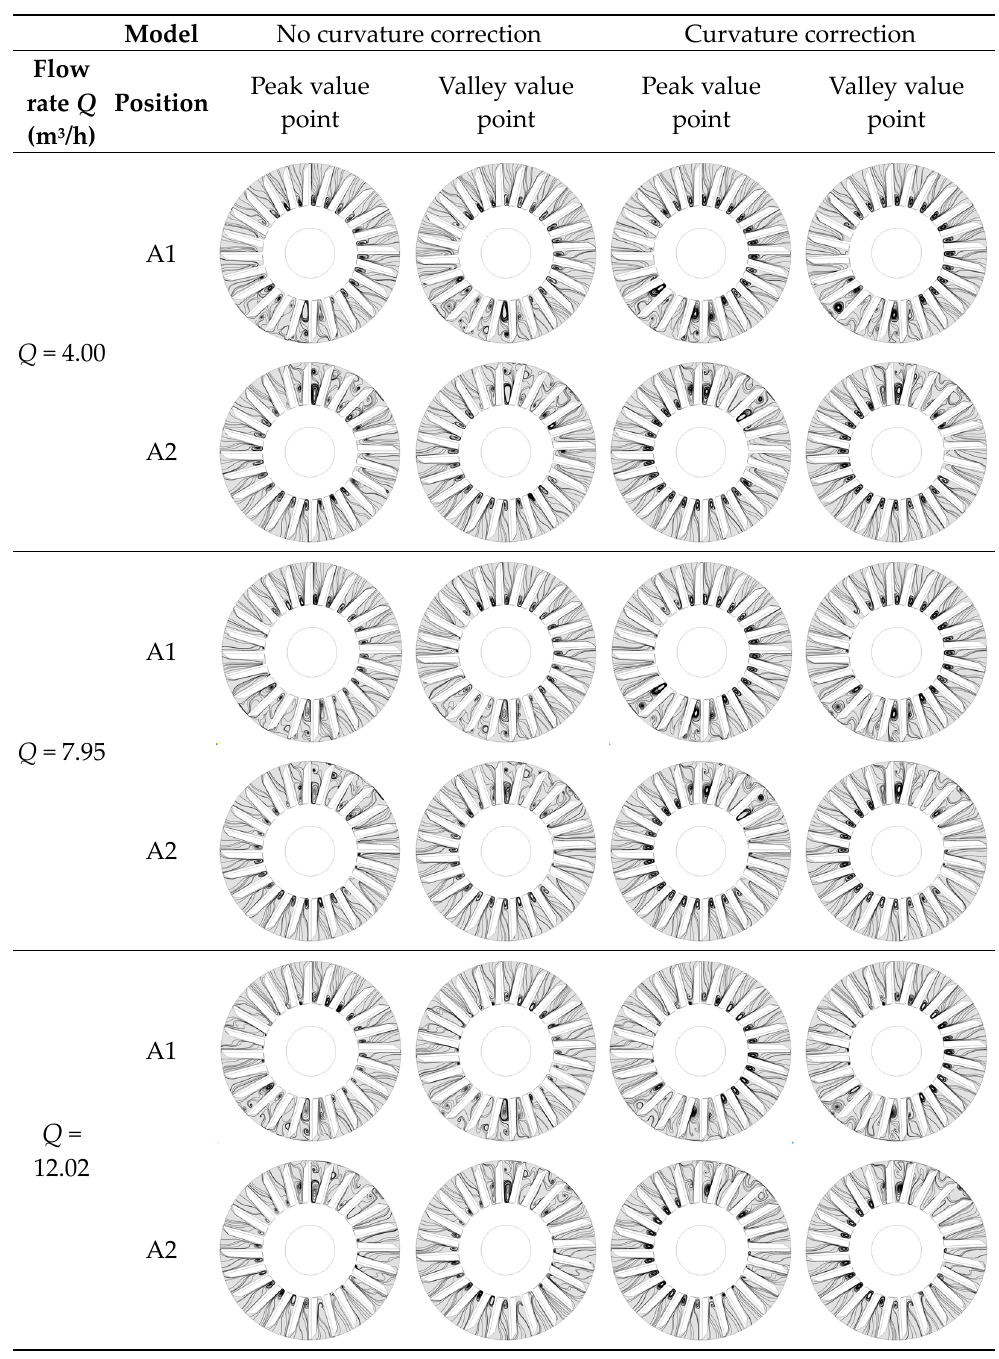
Figure 15. Streamline distribution based on the DES model, with or without curvature correction at A1 and A2 near the outlet at the peak and valley points of the head.